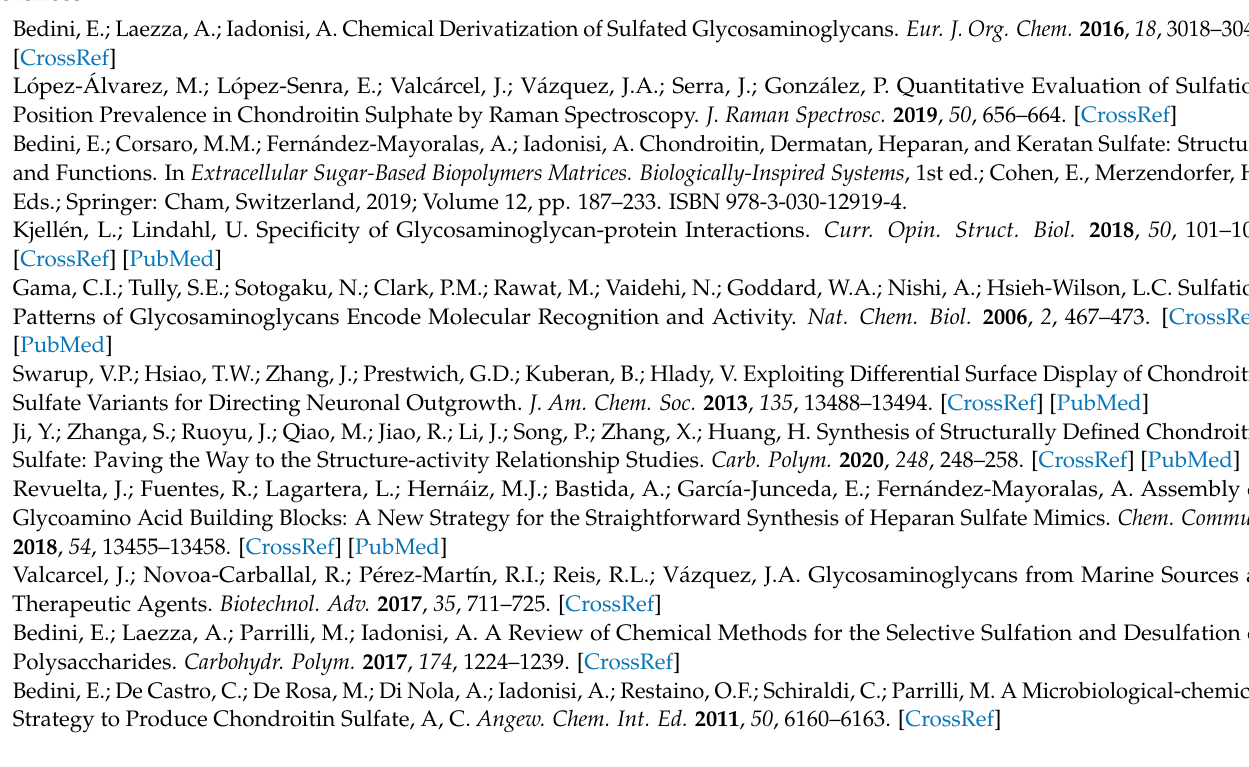
12 , Figure S5: SPR sensograms for binding affinity measurements for FGF-2/ CS-1 interactions, Figure S6: SPR sensograms for binding affinity measurements for FGF-2/CS-7 interactions, Figure S7: SPR sensograms for binding affinity measurements for FGF-2/CS-15 interactions, Table S1: 1 H and 13 C NMR chemical shift attribution of CS-7, Table S2: 1 H and 13 C NMR chemical shift attribution of CS-8 , Table S3: 1 H and 13 C NMR chemical shift attribution of CS-11, Table S4: 1 H and 13 C